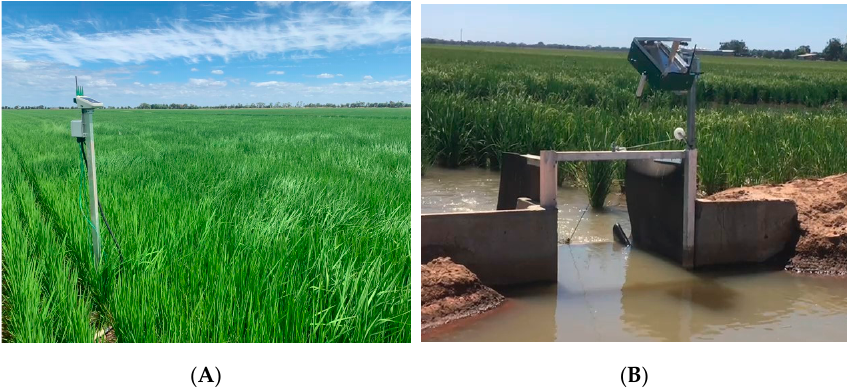
Figure 1. Automation infrastructure used at Site A. ( A ) Padman Automation SensorPro IoT communication towers used to sense soil moisture tension and water height. ( B ) Padman Automation AutowinchPro portable automated outlet controller used to control Padman rubber lay-flat inserts installed to existing concrete structures (outlet currently closing as water threshold surpassed at IoT